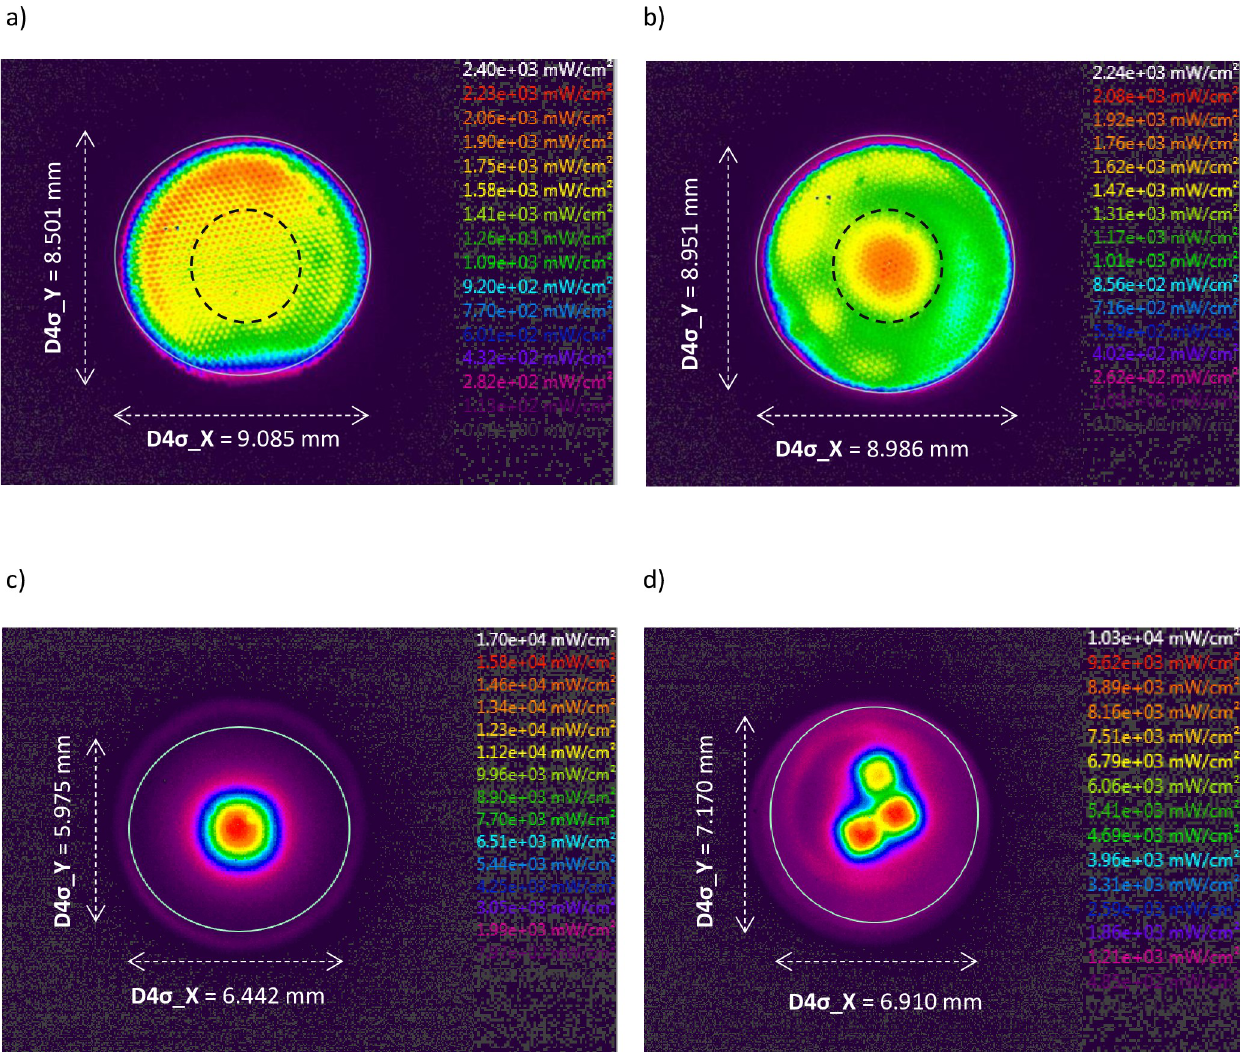
Fig 7. Beam profiles of the (a) Elipar Deep Cure and (b) Elipar S10 units. The beam widths in both the horizontal and vertical directions (x and y, respectively) are given by D4 σ which is 4 times σ , where σ is the standard deviation of the horizontal or vertical marginal distribution respectively. Note the more uniform color-coded irradiance distribution across the exit window face of the Deep Cure light guide compared to the central "high spot" peak irradiance region for the S10. The dotted lines represent the beam area that faced the 4 mm cosine corrector of the MARC LC lower sensor. The images explain why the irradiance ranking for these two LCUs reverses when the irradiance is measured over the central 4 mm diameter region of the beam in comparison with irradiance calculated from the total power output related to the optically active area of the light guide (9 mm diameter). Fig (c) and (d) show the local irradiance distributions for the Satelec Supercharged and Spark SK-L036A units, respectively. Readers should note that these images use different irradiance scales.